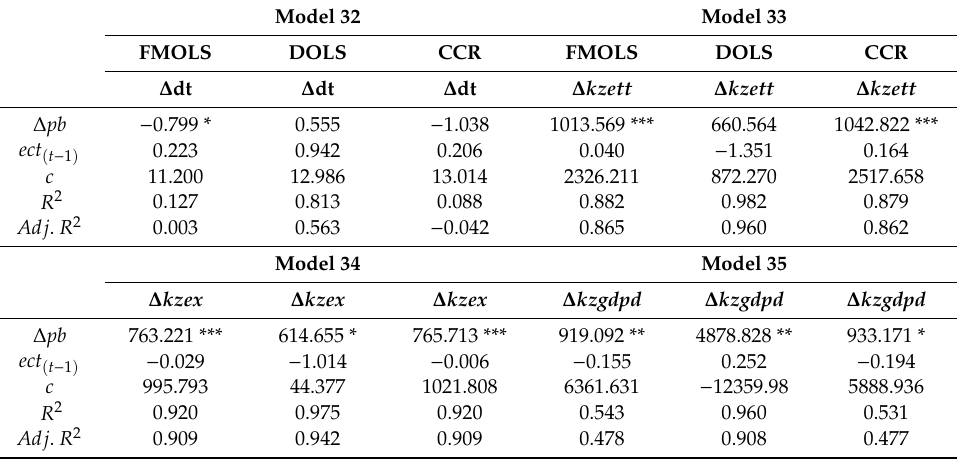
Table 16. The influence of oil price on macroeconomic indicators (Kazakhstan).